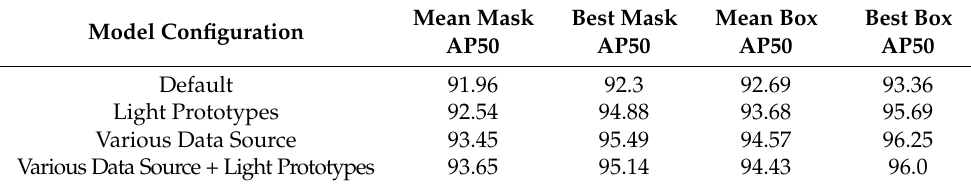
Table 10. Performances of the models with different high-performance